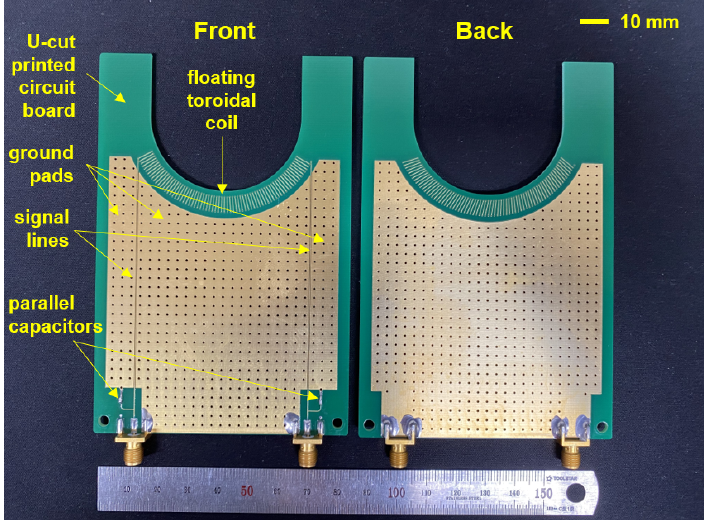
Figure 5. Photograph of the fabricated FTC embedded in a PCB showing both front and back